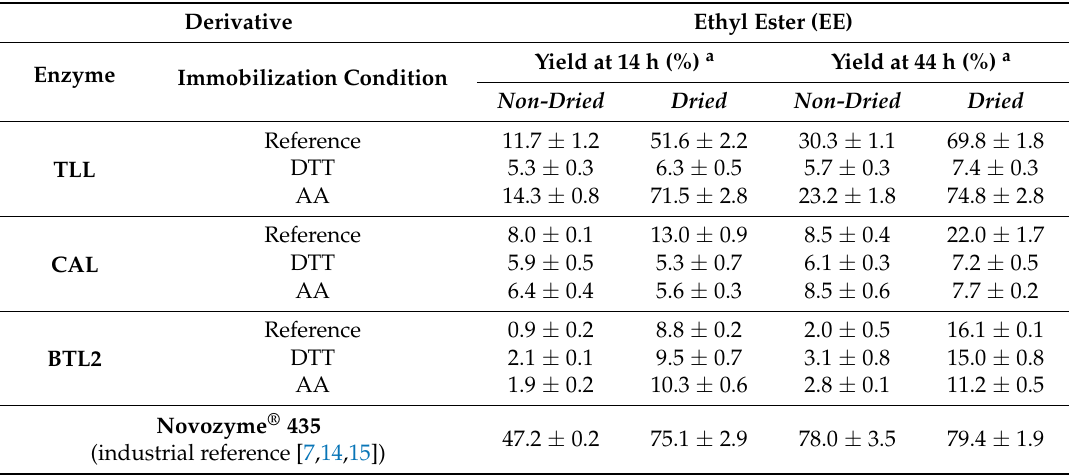
Table 5. Ethyl ester production catalyzed by novel and reference biocatalysts.